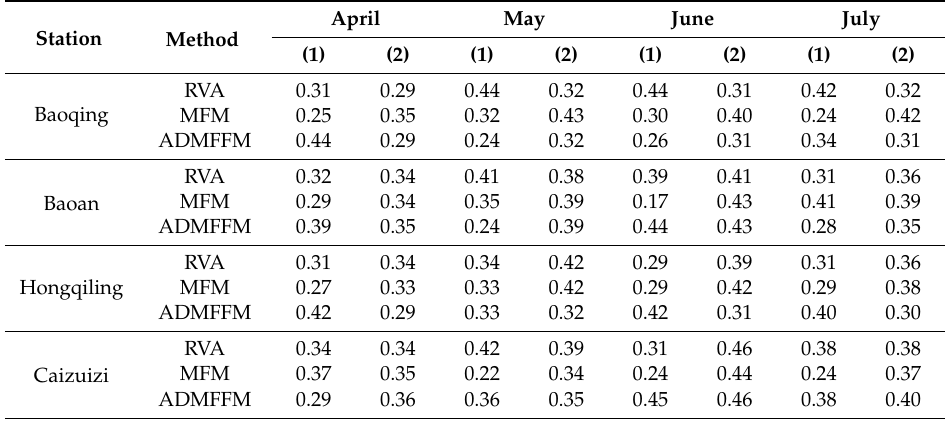
Table 3. Weights of ecological flow calculated by RVA, MFM, and ADMFFM based on the subsequence series and the entire series,